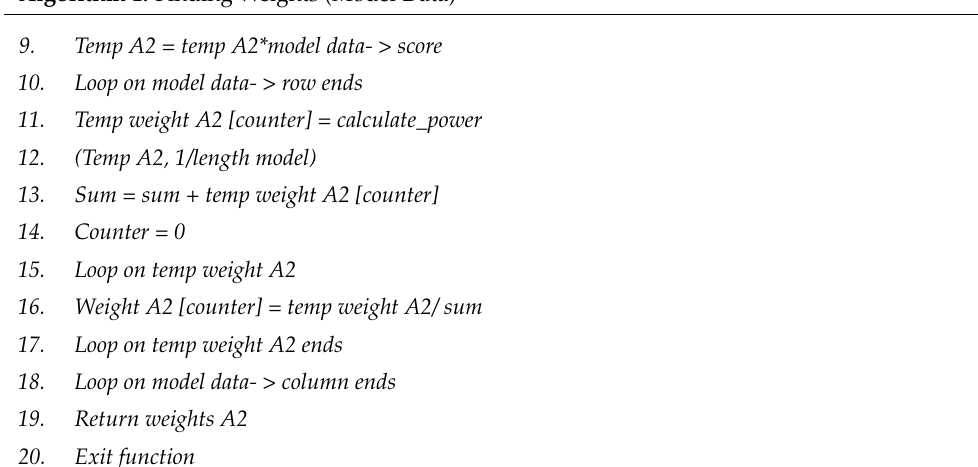
Algorithm 1: Finding Weights (Model Data)